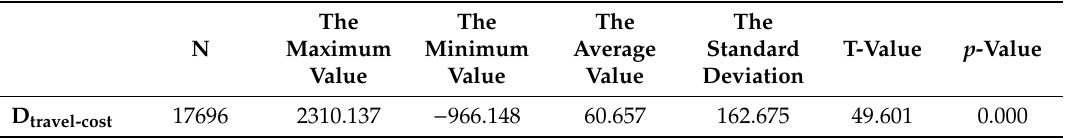
Table A2. The result of the paired-samples T-test.